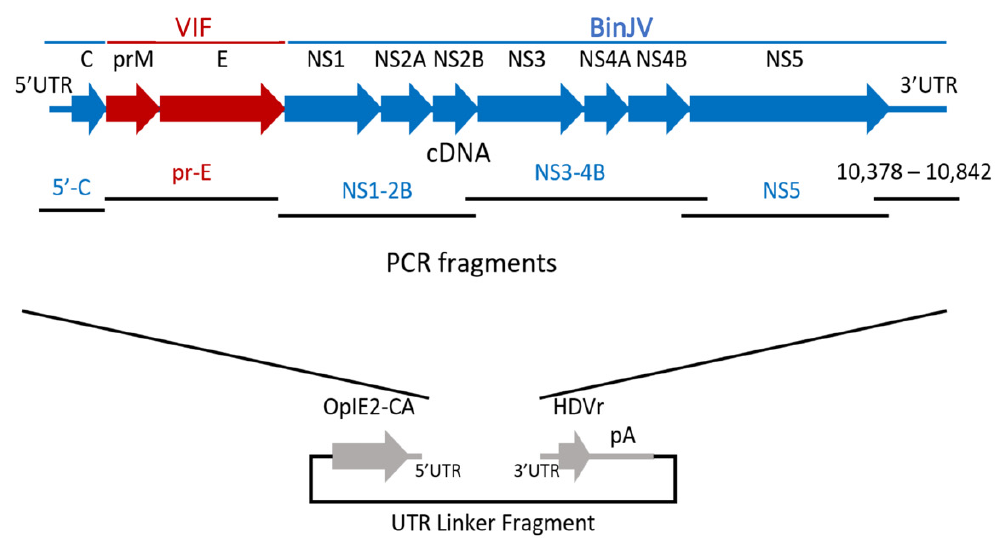
Figure 3. Schematic of the CPER strategy to generate infectious DNA of chimeric BinJ/VIF-prME viruses. BinJ/VIF-prME chimeric viruses are generated by amplifying DNA fragments that share overlapping terminal regions before annealing together in CPER and transfecting mosquito cells with the reaction. Figure adapted from [69]. Table 4. Published ISF/VIF-prME chimeric viruses generated by CPER.